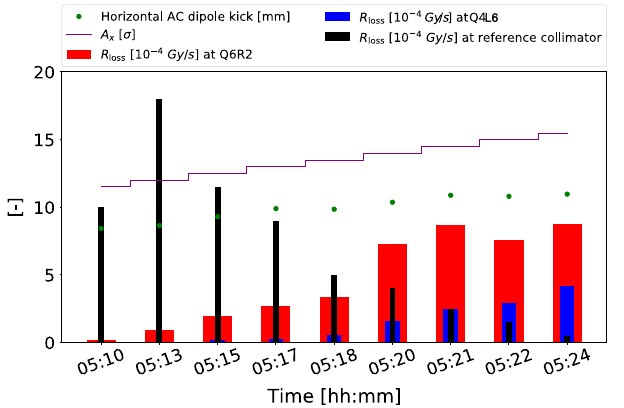
FIG. 4. Raw BLM signal at the bottlenecks Q6R2 (red) and Q4L6 (blue) and at the reference collimator (black), horizontal ac-dipole kick being applied in mm (green) and reference collimator half-gap in units of beam size from aperture mea- surements performed in 2017 at the LHC injection energy of 450 GeV. The measured aperture value of the bottlenecks is 12 . 7 σ for Q4L6 and 12 . 9 σ for Q6R2. Note that during these measure- ments, synchronized with the ac-dipole excitation, losses were only observed at Q6R2, Q4L6, and at the reference collimator. Adapted under CC BY 4.0 license from